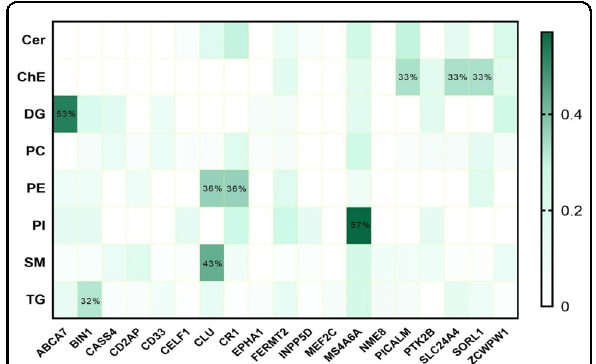
Fig. 6 Proportion of lipids signi fi cantly differentially associated with AD-related genes. ABCA7 ATP binding cassette subfamily A member 7, BIN1 bridging integrator 1, CASS4 Crk associated substrate 4, CD2AP CD2 associated protein, CD33 sialic acid binding Ig-like lectin 3, CUGBP elav-like family member 1, CLU clusterin, CR1 complement C3b/ C4b receptor 1, EPHA1 EPH receptor A1, FERMT2 FERM domain containing kindlin 2, INPP5D inositol polyphosphate-5-phosphatase D, MEF2C myocyte enhancer factor 2C, MS4A6A membrane spanning 4- domains A6A, NME8 NME/NM23 family member 8, PICALM phosphatidylinositol binding clathrin assembly protein, PTK2B protein tyrosine kinase 2 beta, SLC24A4 solute carrier family 24 member 4, SORL1 sortilin related receptor 1, ZCWPW1 zinc fi nger CW-type and PWWP domain containing